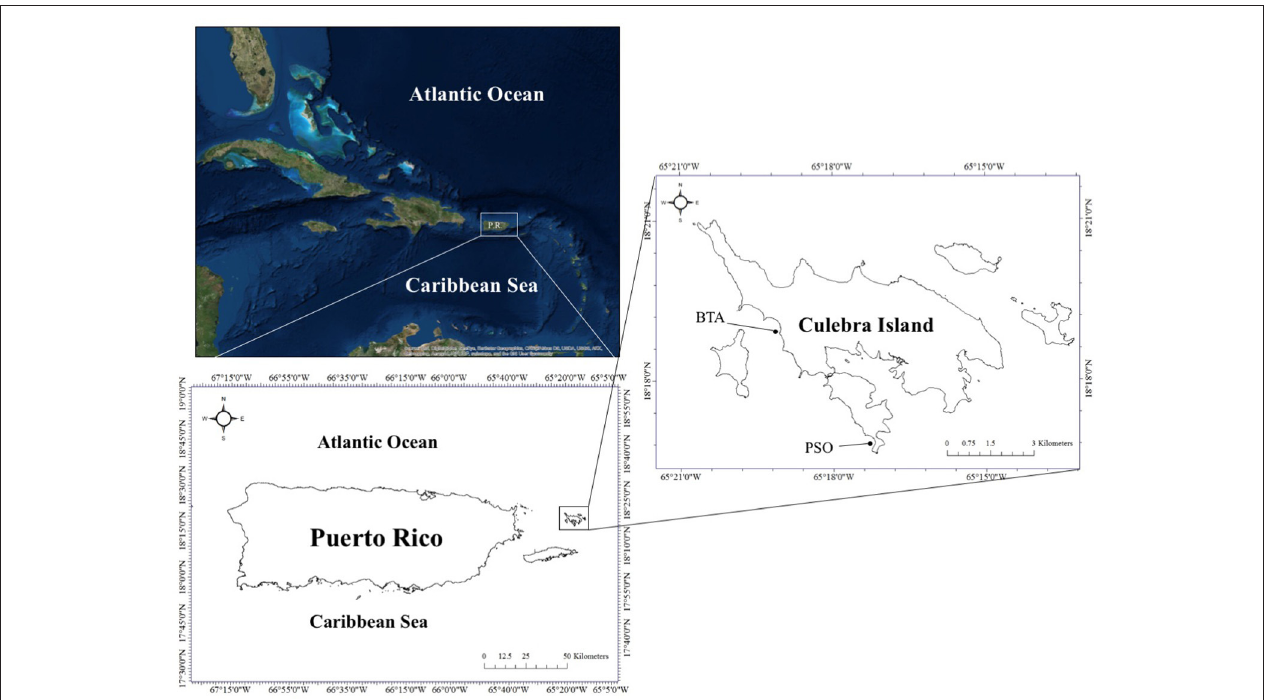
FIGURE 1 | Study site at Culebra Island, Puerto Rico. BTA, Bahia Tamarindo; PSO, Punta Soldado.